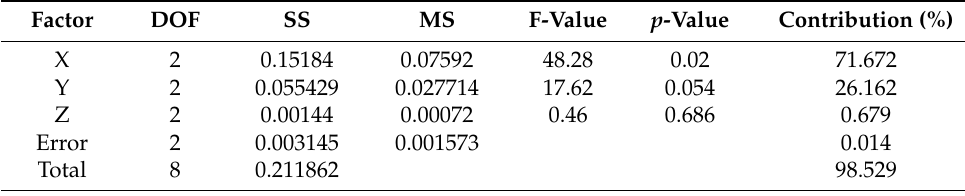
Figure 4. SN ratio plot for the MRR. Table 7. ANOVA for the MRR for the MHD approach.